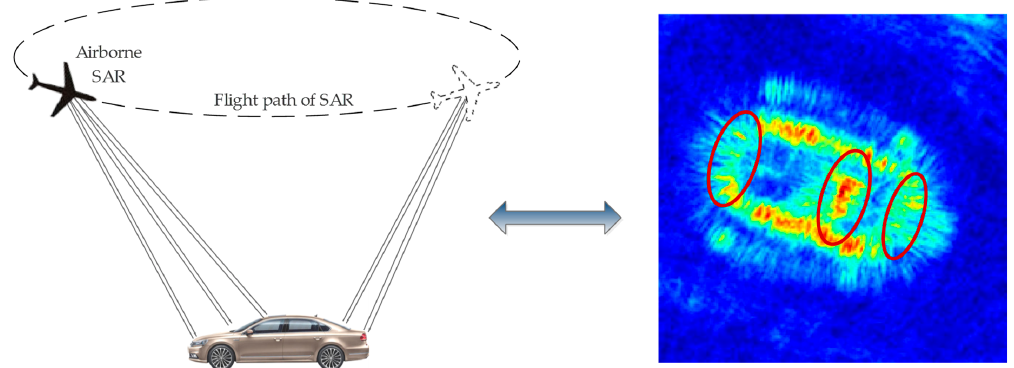
Figure 2. A diagram of circular SAR imaging. The picture on the left illustrates the process of airborne SAR flying around a ground target in a circle. The image on the right is the result of imaging the echo data using a backprojection algorithm. The part marked by the red circle in the right image corresponds to the high reflection part in the front or rear of the vehicle in the left image.